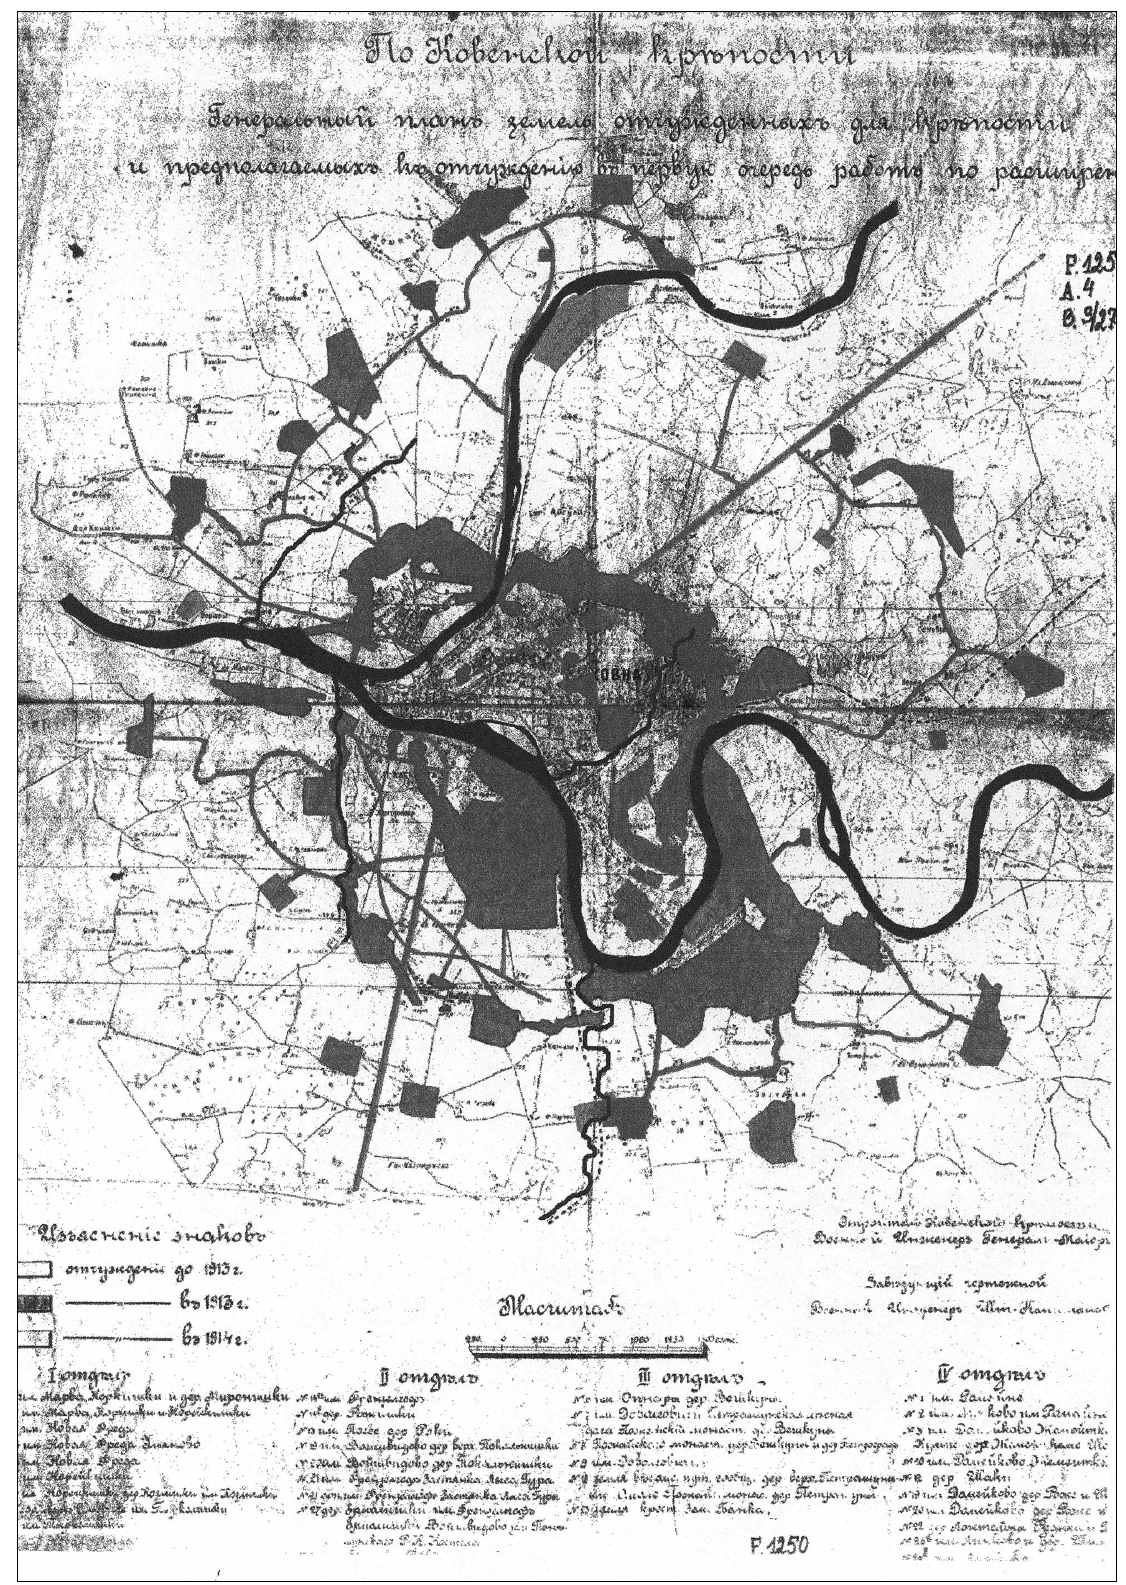
Fig 6. Plan of Kaunas Fortress (1912) and land areas intended to be utilized fo expanding the Fortress (Lithuanian State Archive, Fund 1250, Inventory 4, Case